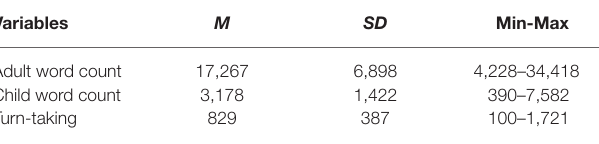
TABLE 5 | Descriptive data for three measures of the home sound environment obtained from the Language ENvironment Analysis (LENA, n = 84). Variables M SD